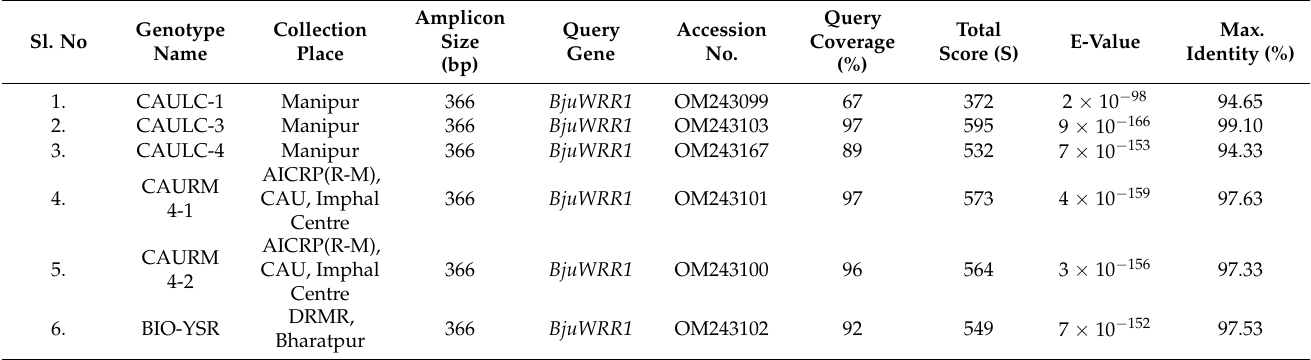
Table 4. BLASTn result with the query and sequenced amplicon.